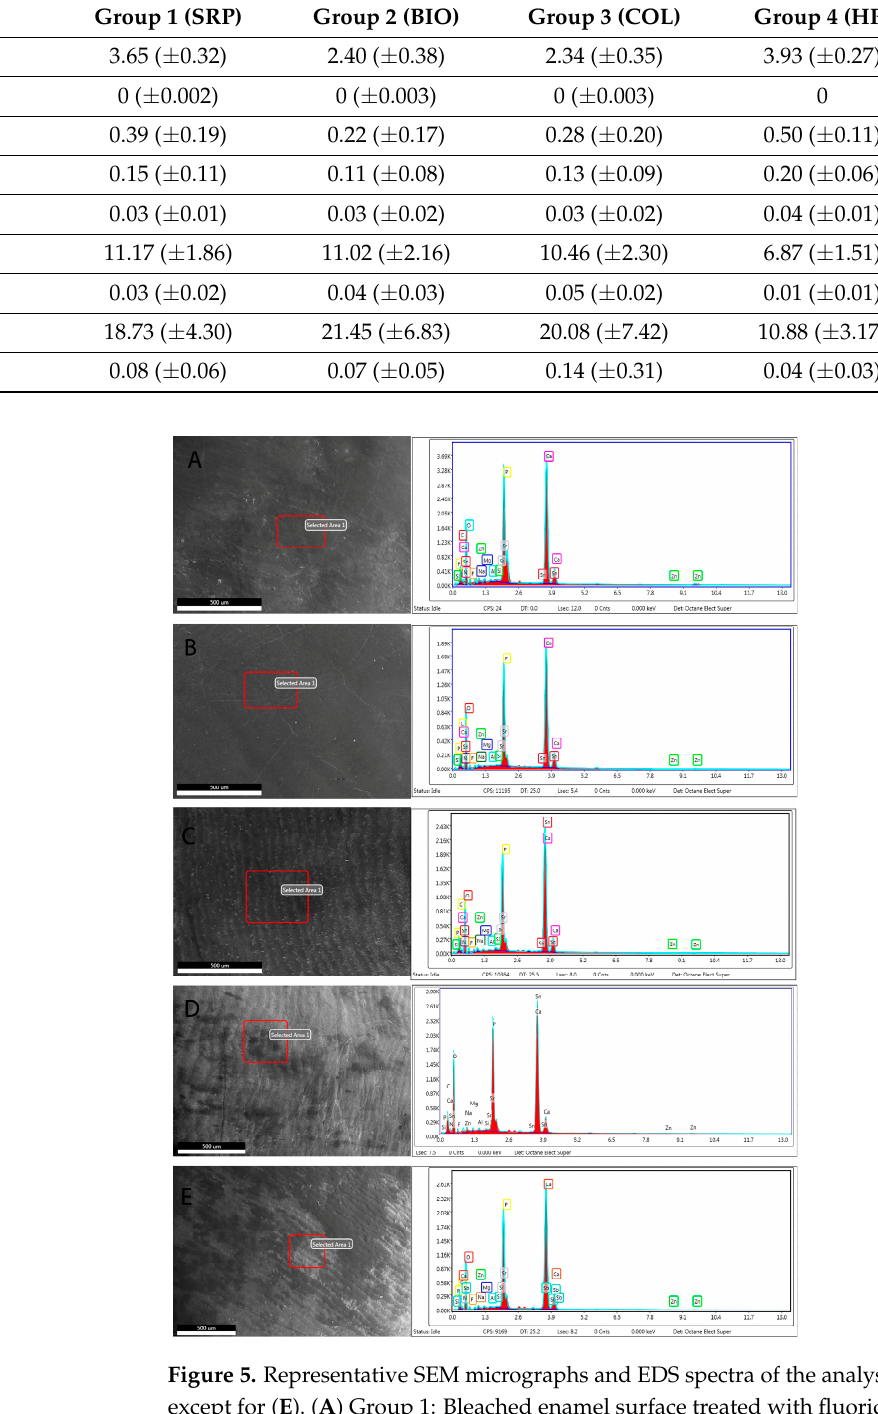
Figure 5. Representative SEM micrographs and EDS spectra of the analysed area for enamel surfaces except for ( E ). ( A ) Group 1: Bleached enamel surface treated with fluoridated toothpaste containing